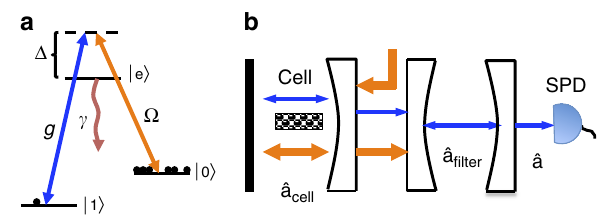
Figure 1 | Atomic level structure and experimental setup. ( a ) All atoms are initially pumped to state |0 i . The transition |0 i - | e i is driven by a weak laser field ( O ), while the cavity mode ( g ) couples | e i and |1 i . The driving is far detuned D (cid:2) g ð Þ from the excited level to suppress the effects of Doppler broadening and absorption. g is the decay rate of the excited level | e i . ( b ) The atomic ensemble is kept in a small cell inside a single-sided cavity with a low finesse (cell cavity). The quantum photons (thin arrows) are coupled from the cell cavity into a high-finesse cavity (filter cavity), which separates them from the classical field (thick arrows) and averages over the atomic motion. Finally, the quantum photons are measured with a SPD. We associate the quantum field inside the cell cavity (filter cavity) with an annihilation operator ^ a cell ^ a filter ð Þ , while the field at the detector is associated with the annihilation operator ^ a . SPD, single-photon